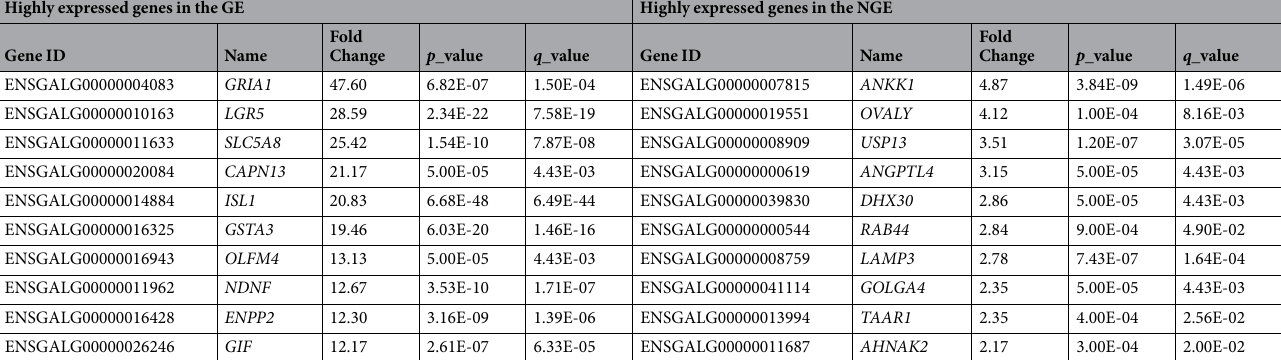
Table 1. Top 10 DEGs in GE and in NGE in comparison between GE and NGE.